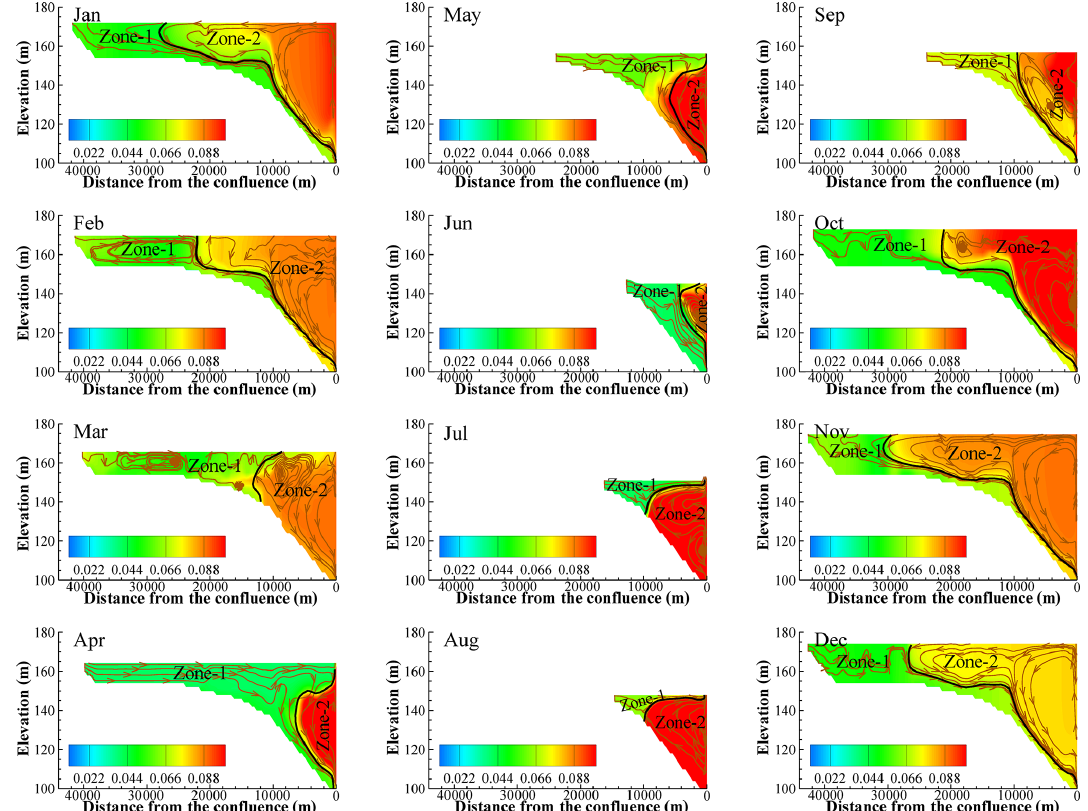
Figure 13. Distribution of TP in each month. The black curve in the figure is the boundary between zone 1 and zone 2. The brown curves with arrows are